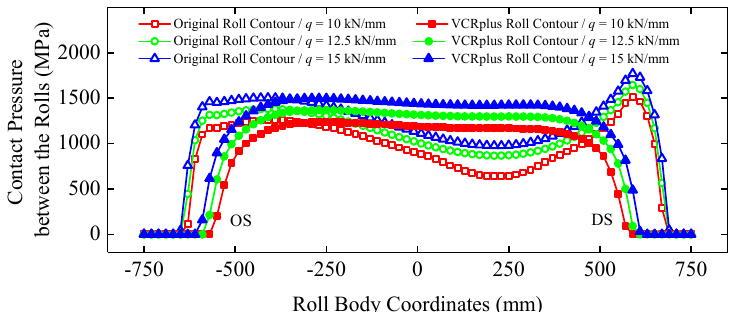
Figure 12. Comparison of the contact pressure between the rolls at different rolling forces q ( S = 0 mm, B = 1200 mm). Table 6. The coefficient, K , at different strip widths, B .